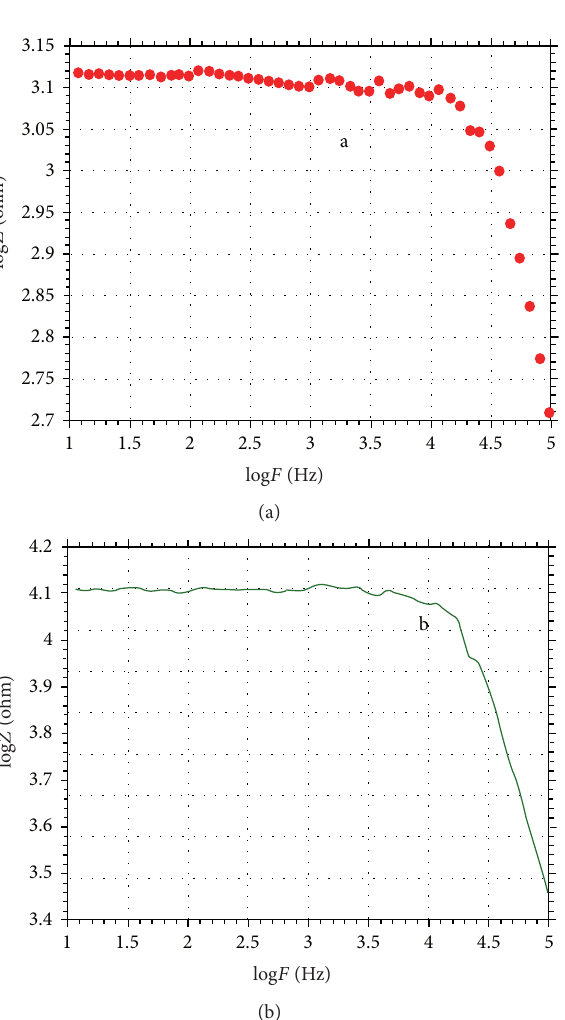
of carbon steel specimen immersed in well water for 7 days in the absence and presence of inhibitor system are shown in Figures 5(a), 5(b), and 5(c), respectively. (control) in Figure 5(a) show the smooth surface of the metal. is shows the absence of any corrosion products (or) inhibitor complex formed on the metal